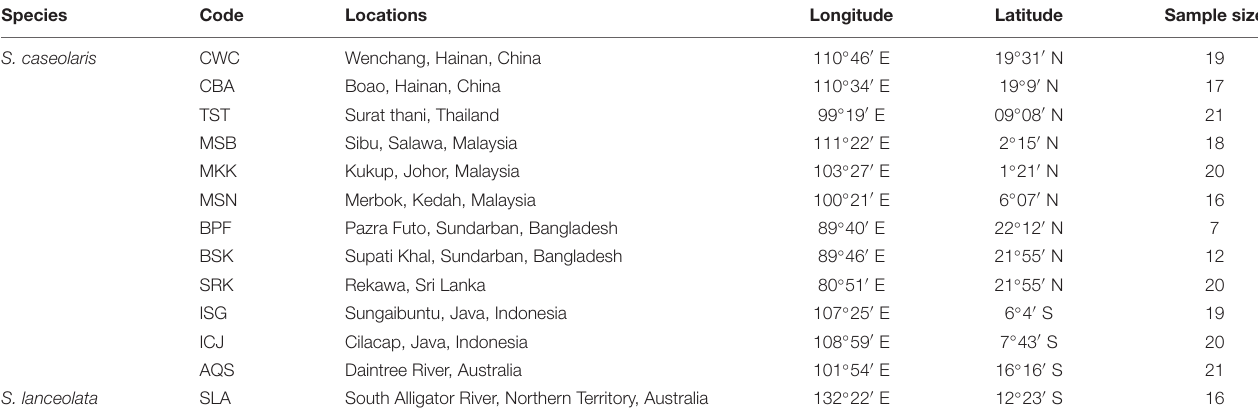
TABLE 1 | Locations and sample sizes of the 12 Sonneratia caseolaris populations and the single S. lanceolata population used in this study. Species